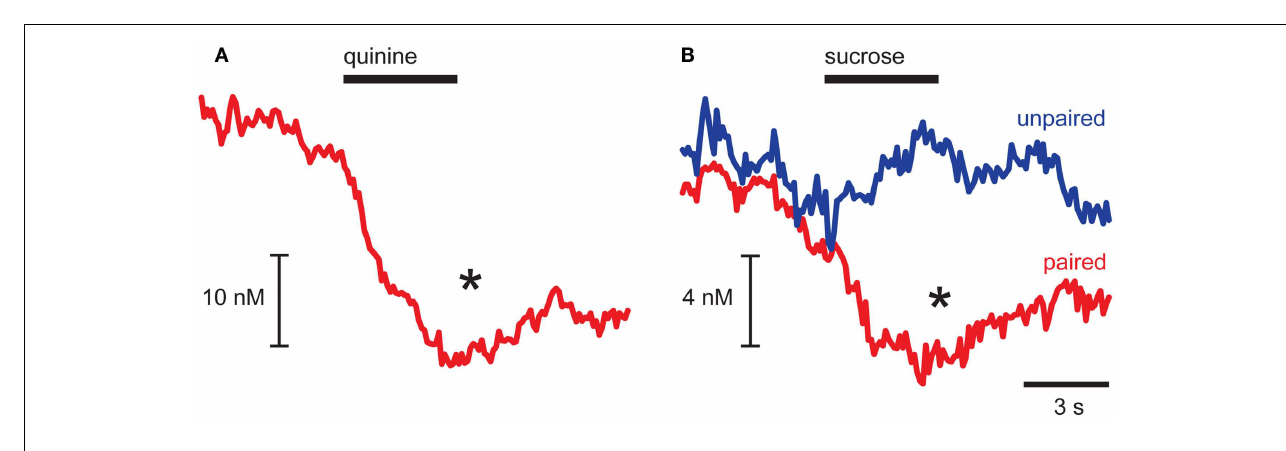
infusions in Paired rats [ (B) , red trace] and no change in dopamine release in Unpaired rats [ (B) , blue trace]. * p < 0.05 pre-infusion vs. infusion